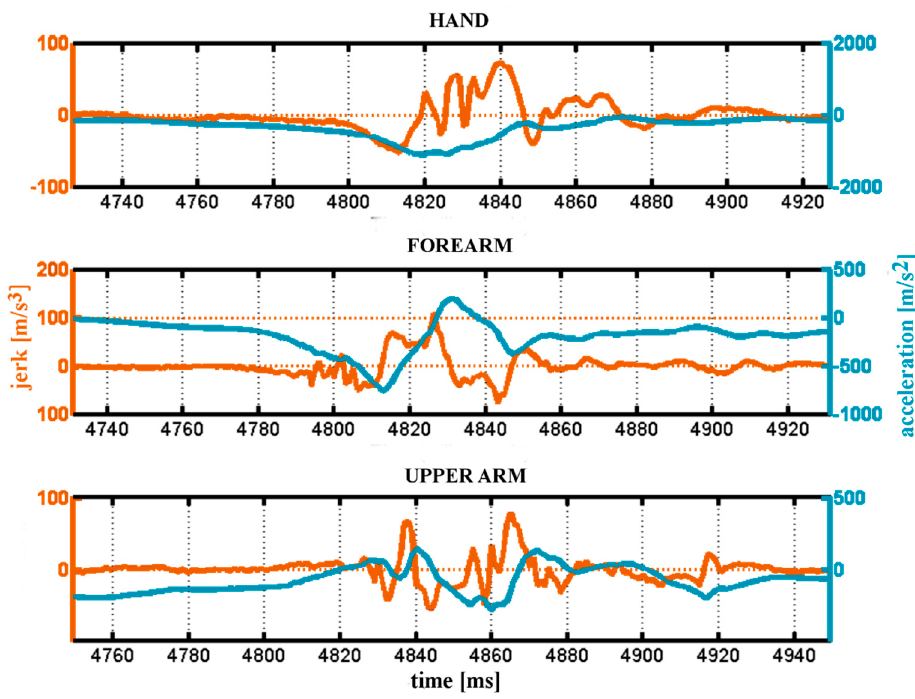
Figure 6. Peaks of acceleration and jerk do not happen at the same moment and have different dynamics.